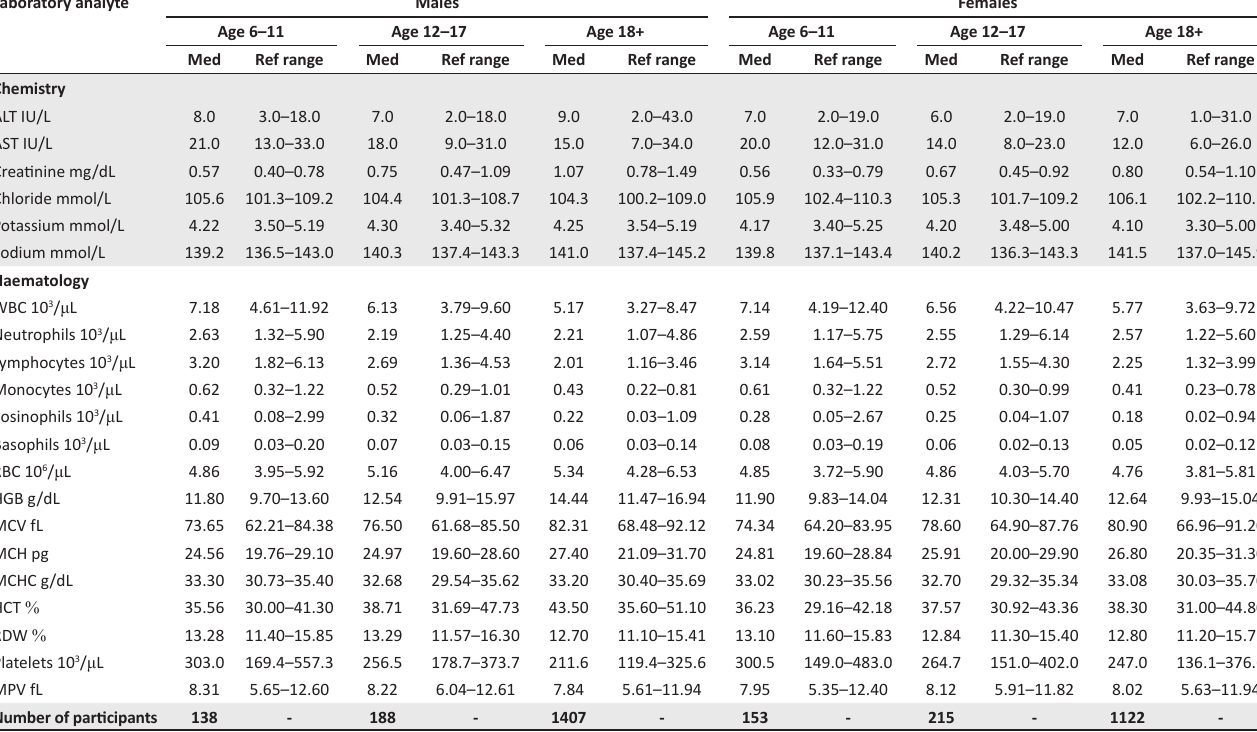
TABLE 2: Median and reference ranges for chemistries and haematology by gender and age group: Monrovia, Liberia 2015–2017. Laboratory analyte